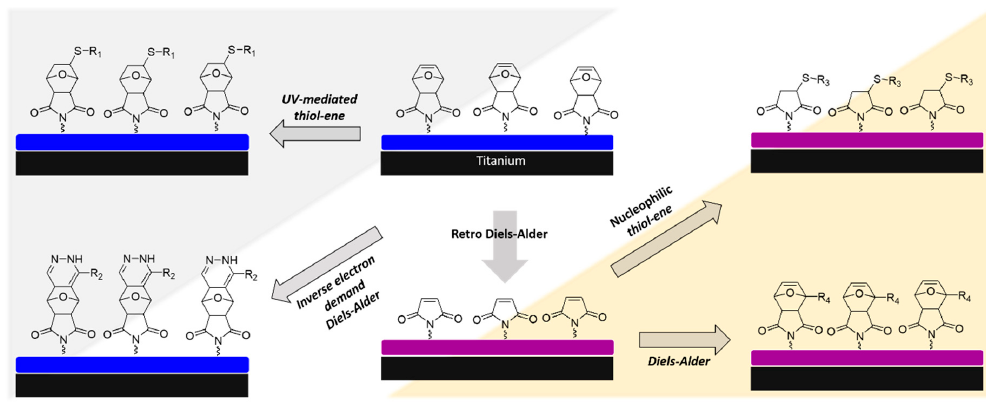
Scheme 1. Schematic illustration of multi-functionalizable hydrogel layer on titanium substrates using various click reactions.